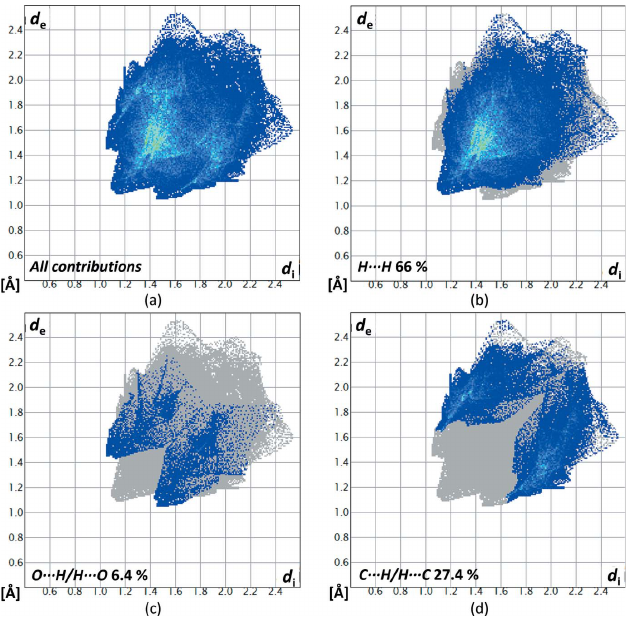
Figure 9 Two-dimensional fingerprint plots for compound 2 , showing ( a ) all contributions, and ( b )–( d ) delineated showing the contributions of atoms within specific interacting pairs (blue